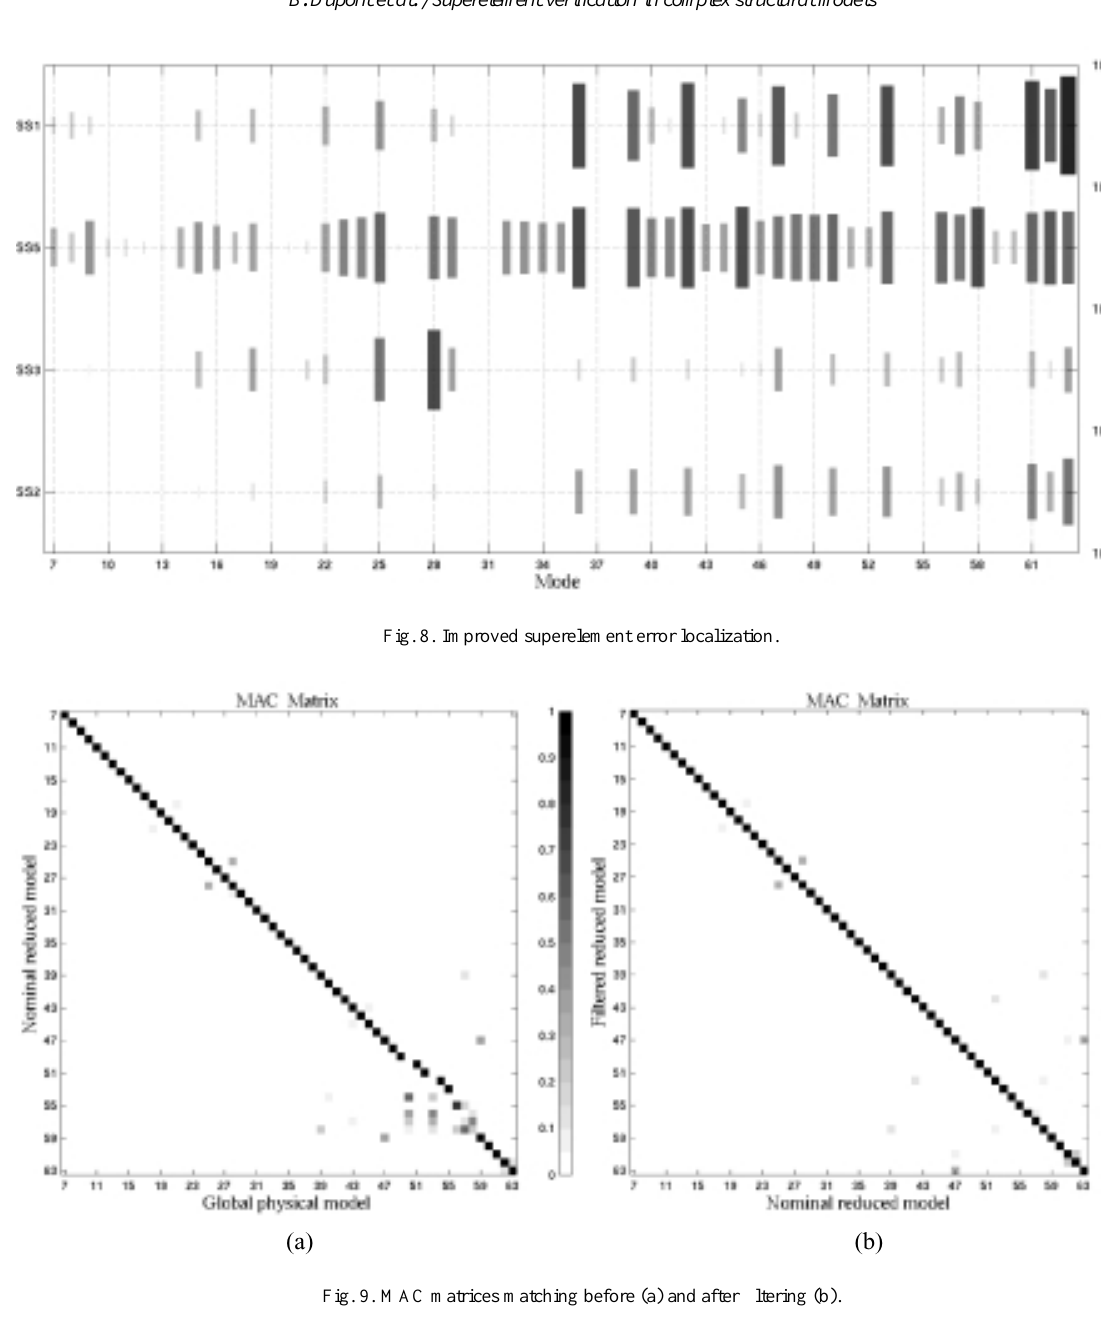
Fig. 9. MAC matrices matching before (a) and after filtering